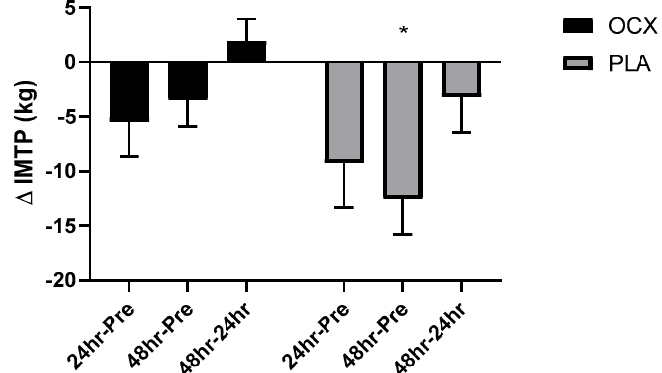
Figure 2. Bar charts displaying the mean and standard error for the absolute mean difference in maximal strength assessed by the isometric mid-thigh pull (IMTP) in the Oceanix (OCX) and placebo (PLA) conditions from Pre to 1 day following the cross-training bout (24 h Pre), Pre to 2 days following the cross-training bout (48 h Pre), and 1 day to 2 days following the cross-training bout (48 h–24 h). * = significantly lower than OCX ( p < 0.05).